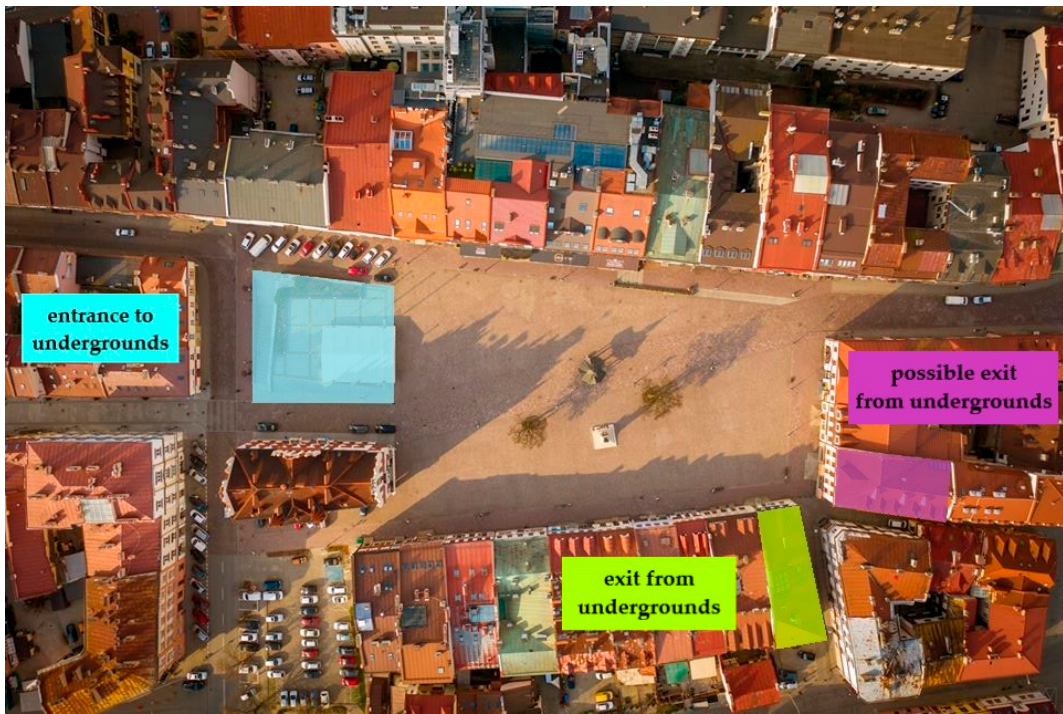
Figure 4. View of the Main Market Square in Rzeszów from above. Source: own study based on the photography of Tomasz Wawszczyk [65].